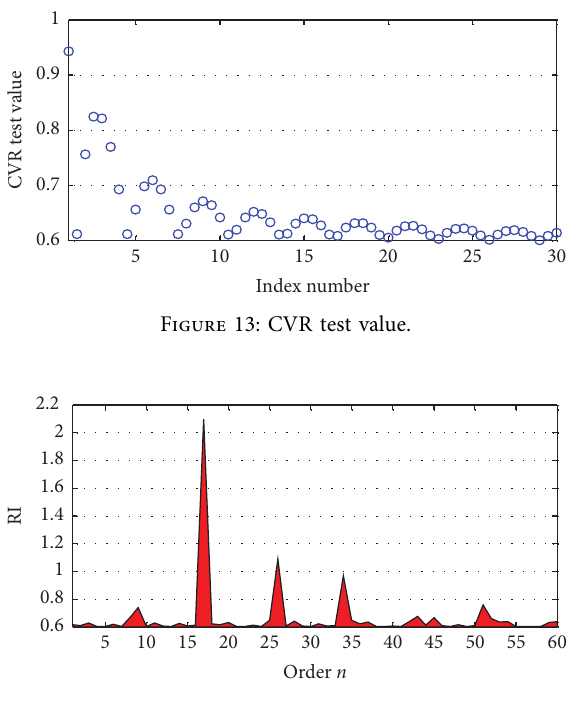
Figure 14: Average consistency